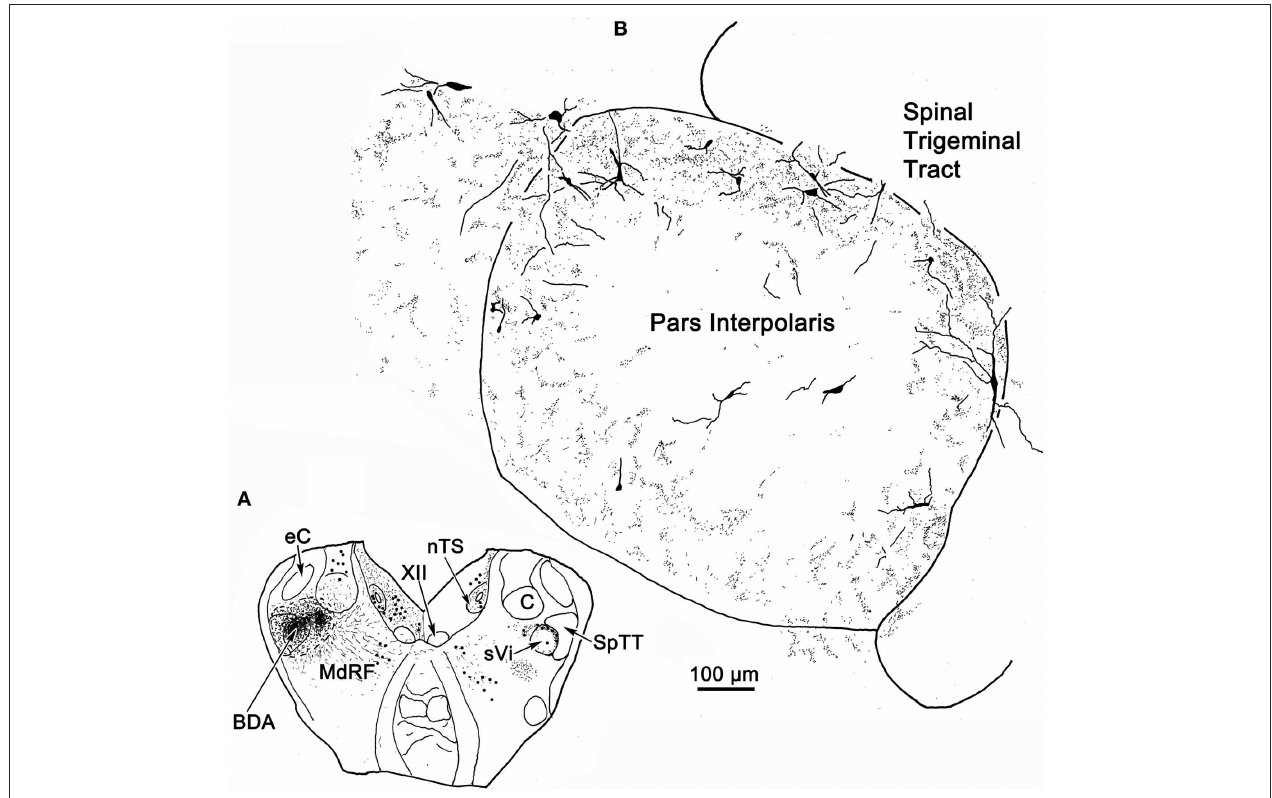
FIGURE 13 | Robust commissural connections between sVi are shown following a BDA injection (A) at the level of the hypoglossal nucleus (XII). The injection extended medially into the adjacent medullary reticular formation (MdRF) and resulted in both retrogradely labeled cells (dots) and